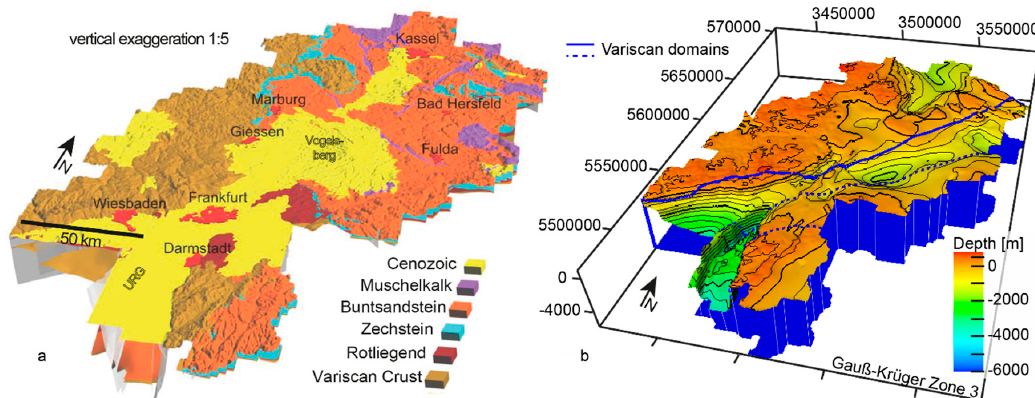
Figure 2. Structural 3D model of Hesse: ( a ) Consisting of six lithological layers and faults (modified after Reference [20]); in this figure the layer surfaces are represented with di ff erent colors for each unit and in ( b ) the depth of the top of the Variscan crust is illustrated in a 3D view with colors from blue to red. The model base in 6 km depth is illustrated as a blue plane. The Variscan crust is subdivided into di ff erent Variscan domains (see Figure 1). The vertical borders between the di ff erent crustal units are approximated as vertical and illustrated as blue lines [21].